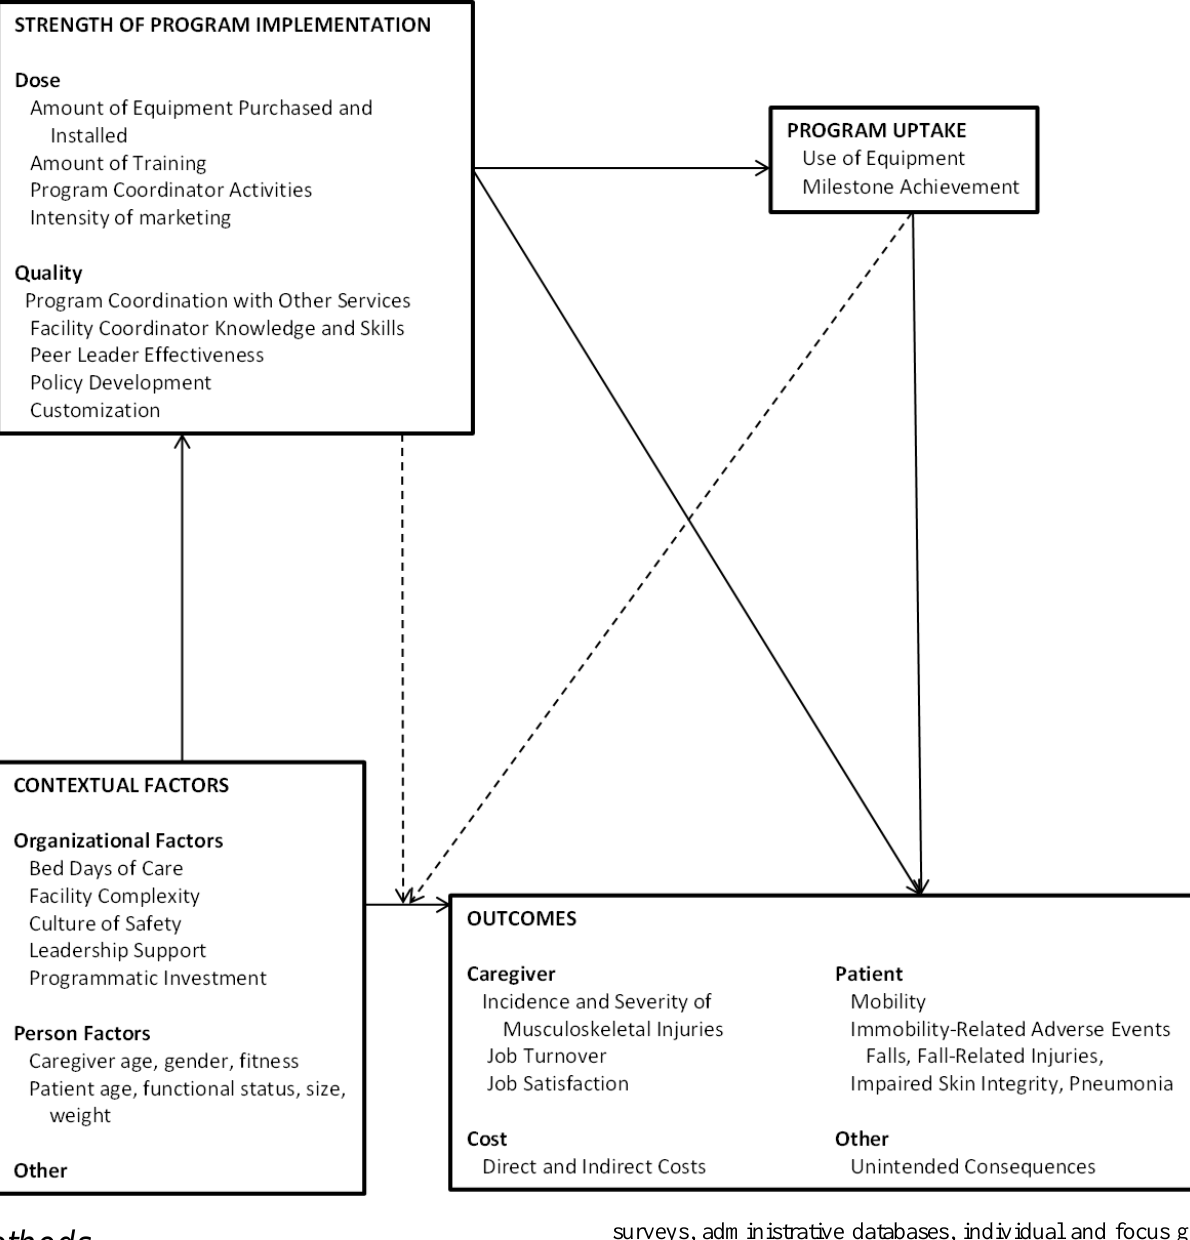
Figure 1. Conceptual framework for the implementation and evaluation of the VA Safe Patient Handling